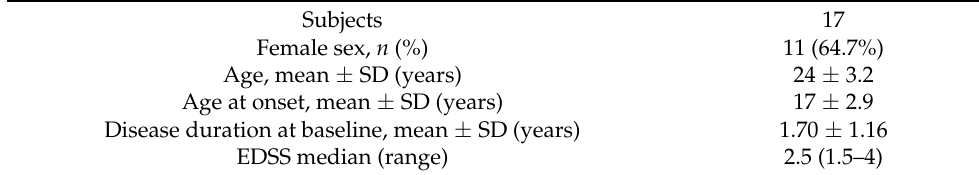
Table 1. Demographic and clinical characteristics of the study population. EDSS: Expanded Disability Status Scale.